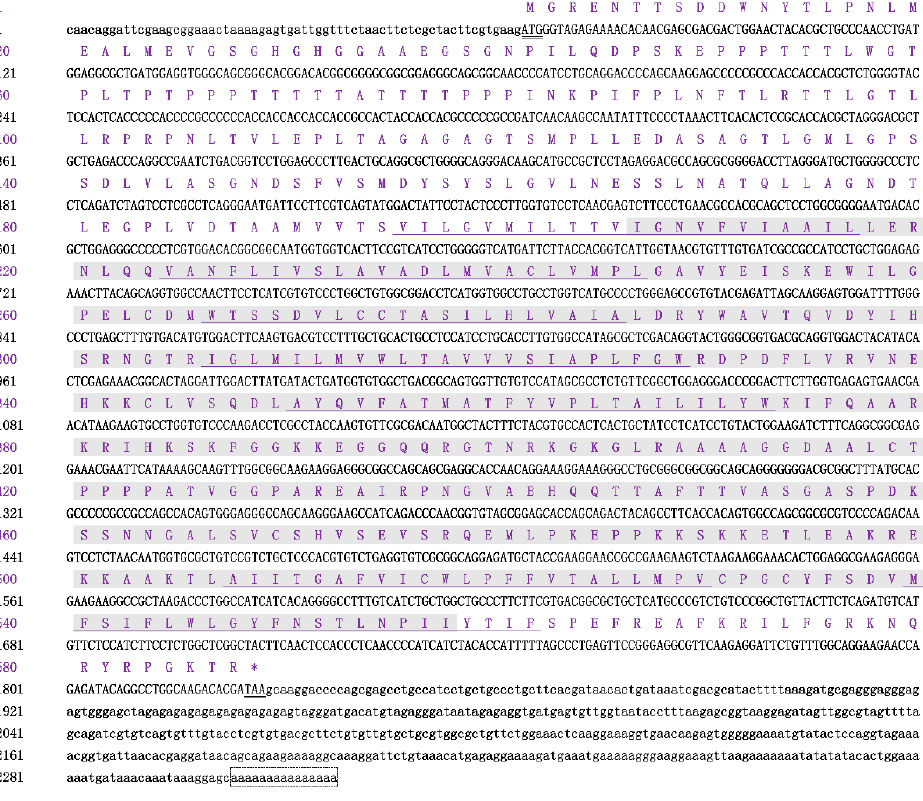
Figure 1. Nucleotide and deduced amino acid sequences of the Sp5-HTR1 gene. The amino acid sequence is shown as single letters underneath the encoding nucleotide sequence. The numbers on the right indicate nucleotide and amino acid numbers. The “7tm_1” domain is shaded in gray. The initiator codon and termination codon are double-underlined. The “*” is represented as a termination codon. The seven transmembrane regions are underlined. Dashed boxes indicate the poly (A) tail. The derived Sp5-HTR1 was similar to the 5-HTR1 of other crustaceans, with the highest similarity of 98.5% to the 5-HTR1 of Portunus trituberculatus , followed by 84.2% and 81.1% similarities to those of Cancer borealis and Procambarus clarkii , respectively (Figure 2A). An evolutionary developmental tree was constructed on the basis of the CRD domain of Sp5- HTR1 and the CRD domains of 5-HTR1 in other invertebrates to reveal the relationship be- tween Sp5-HTR1 and the 5-HTR1 or 5-HTR1 -like peptides in other invertebrates (Figure 2B). The 5-HTR1 of S. paramamosain clustered first with the 5-HTR1 of Portunus trituberculatus and Cancer borealis , then with the 5-HTR1 of Procambarus clarkii , Homarus americanus, and Panulirus interruptus , and lastly with Macrobrachium rosenbergii , Penaeus monodon, and Penaeus japonicus